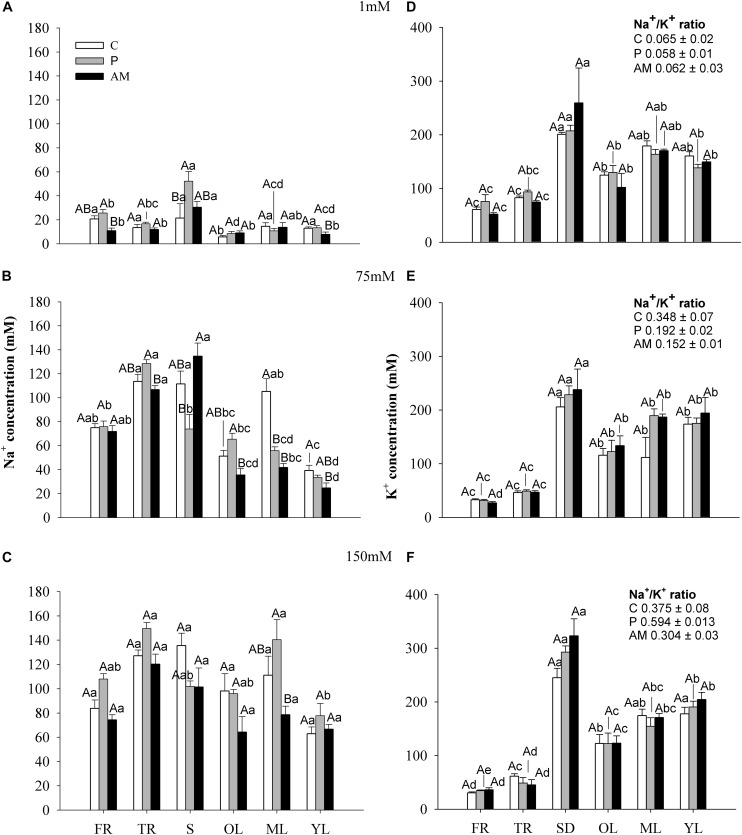
Sodium and potassium concentration: (A–C) show Na+ concentration (mM), and (D–F) show K+ concentration (mM) of different tissues (fine root – FR; thick root – TR; stem – S; old leaf – OL; mature leaf – ML and young leaf – YL) at 1, 75 and 150mM salt levels, of C, P and AM plants (white, gray and black bars, respectively). Values of ML Na+/L+ ratio are show in a nested chart. Values are mean and SE of six replicates. Different capital letters indicate significant differences among nutritional levels (C, P and AM) within the same tissue, and lowercase letters indicate significant differences among tissues within the same nutritional level, from post hoc Tukey test.